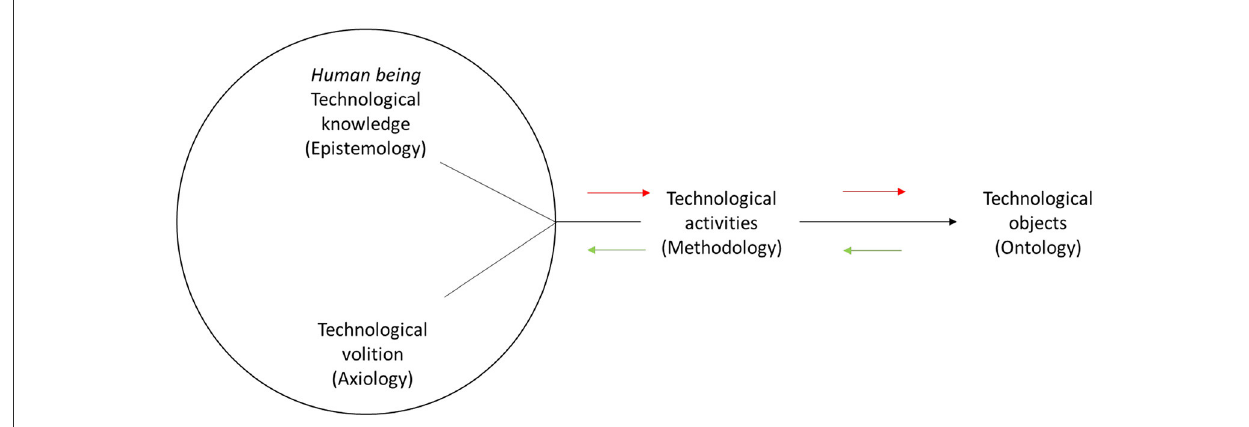
FIGURE1 Modes in which technology is manifested (Mitcham, 1994, p. 160 and 209, as adapted by Ankiewicz et al., 2006 and Ankiewicz,